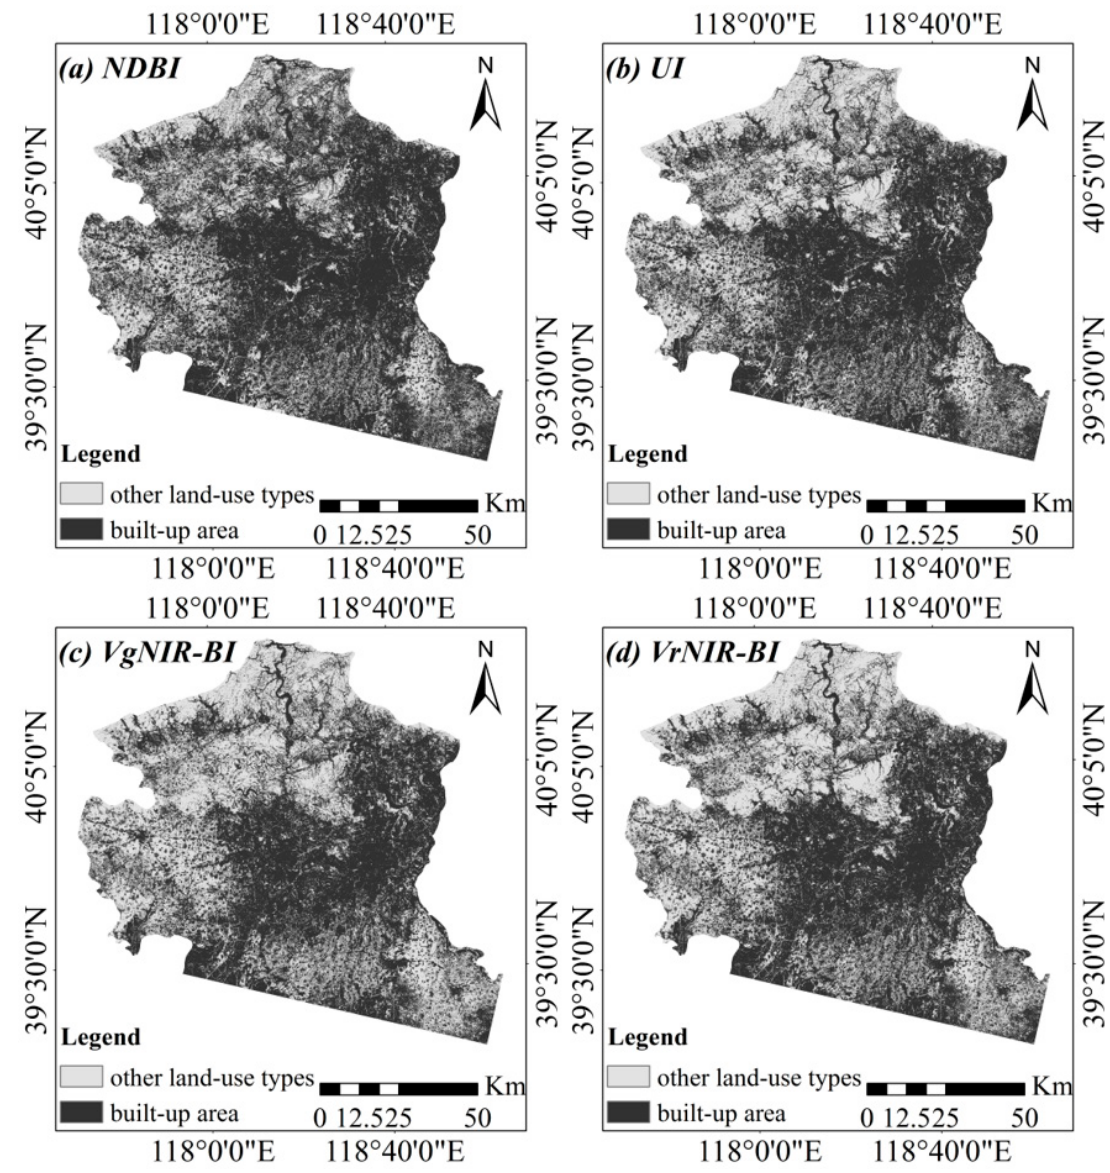
Figure 10. The extraction results of the experimental study area using the normalized difference built-up index (NDBI) ( a ), urban index (UI) ( b ), visible green-based built-up index (VgNIR-BI) ( c ), and visible red-based built-up index (VrNIR-BI) ( d ). Table 5. Accuracy assessment of four other methodologies and the NDSTI. Table 5. Accuracy assessment of four other methodologies and the